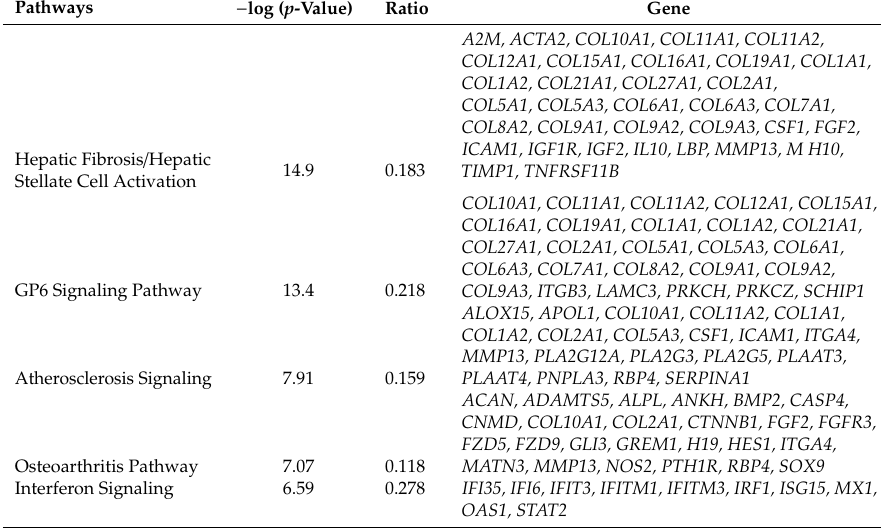
Table 2. Canonical pathways of DEGs of osteochondromas by the ingenuity pathway analysis.